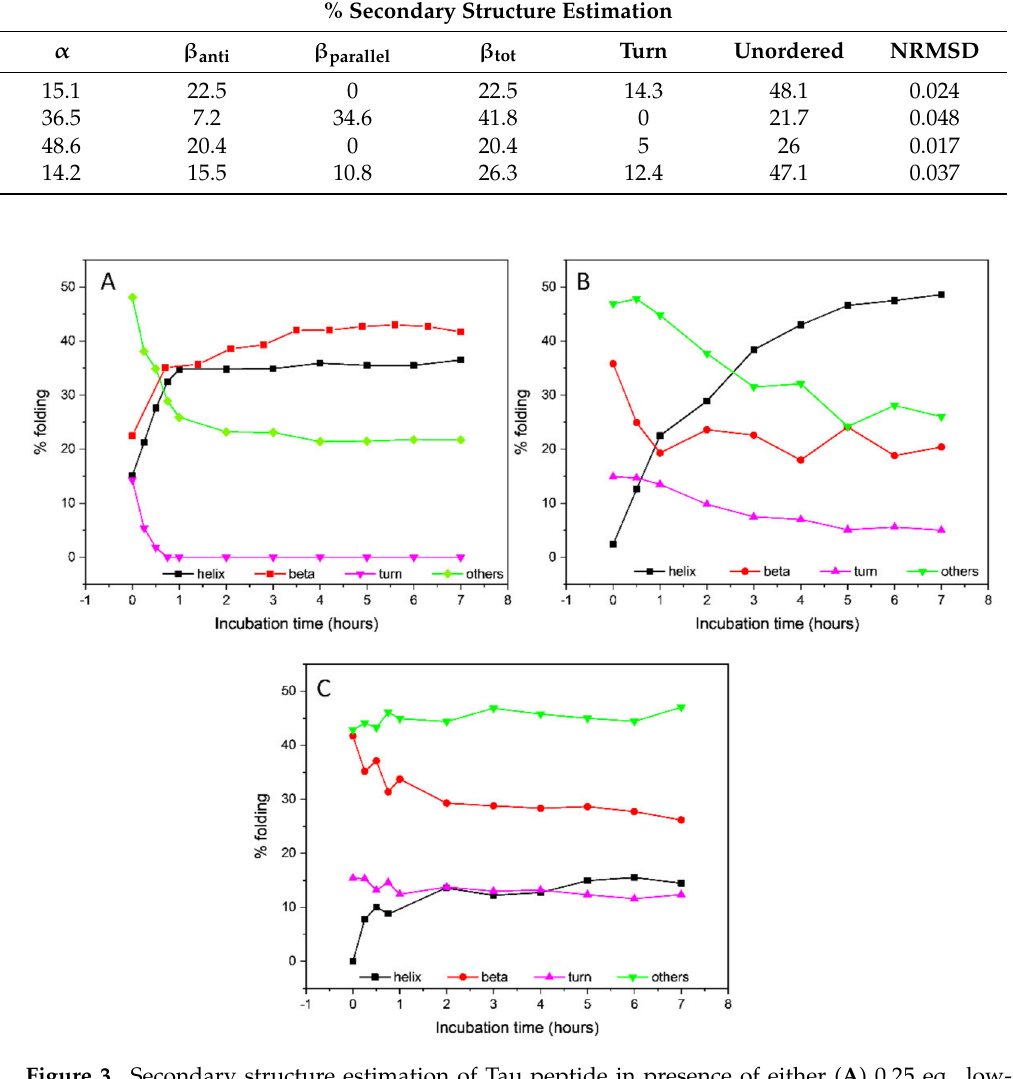
Figure 3. Secondary structure estimation of Tau peptide in presence of either ( A ) 0.25 eq. low- molecular-weight heparin, ( B ) 0.25 eq. heparin and 6 eq. trehalose or ( C ) 0.25 eq. heparin and 6 eq. ceftriaxone throughout 7 h incubation